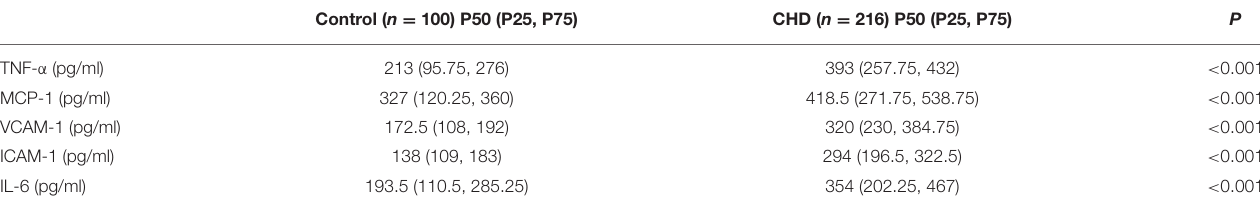
TABLE 3 | Comparison of inflammation-related